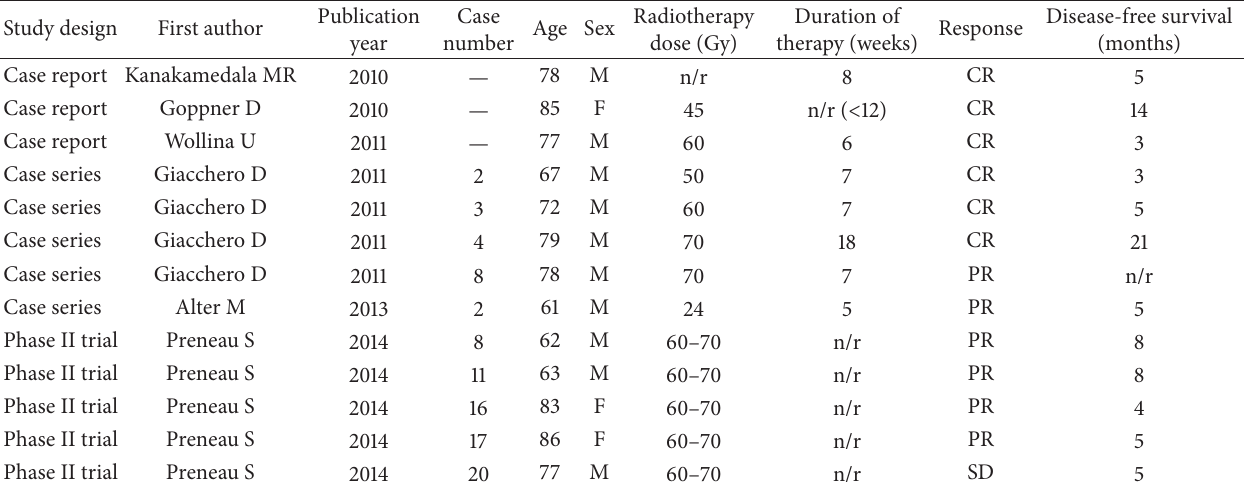
Table 4: Reported cases of cSCC treated with